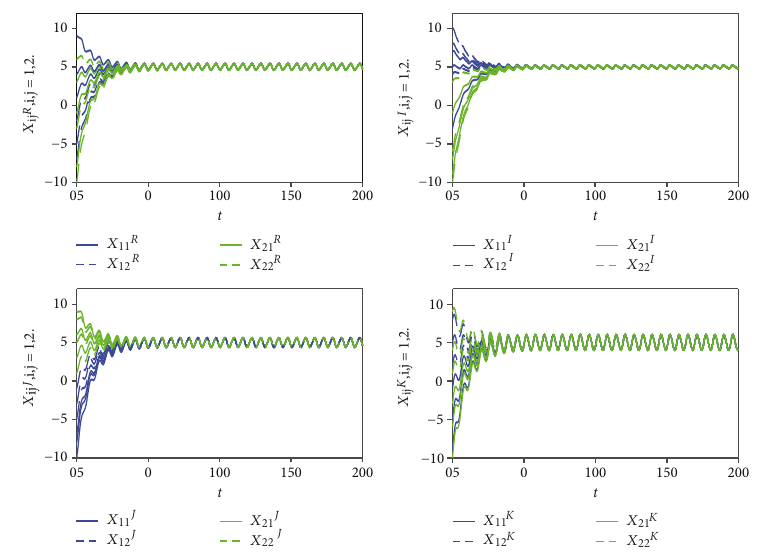
Figure 1: The states of four parts of x